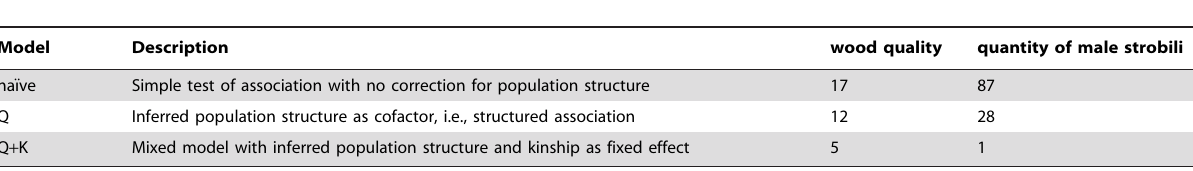
Table 2. Summary of models and number of significant loci at a nominal 1%